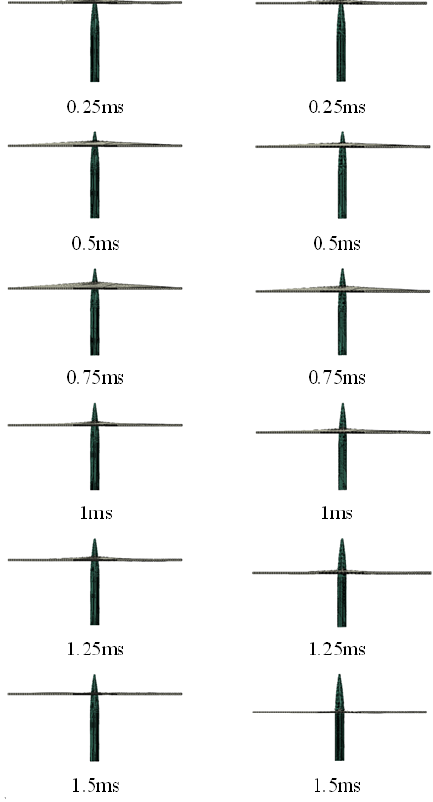
Figure 10. Variation of harpoon impact embedded length (left side is with friction coefficient, right side is without friction coefficient). When the head of the harpoon finishes impacting the target plate, the kinetic energy of the harpoon decreases and gradually loses forward ability, and it is embedded in the target plate due to the mutual friction coefficient and the fluctuation of the target plate deformation. Analysis of the above embedding data when the initial velocity of the